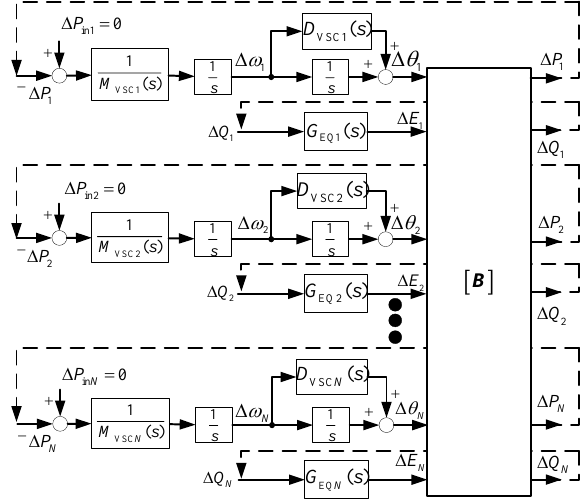
Figure 3. The small-signal model of a weak AC grid connected to multiple PMSG-based WTs in the DC voltage control